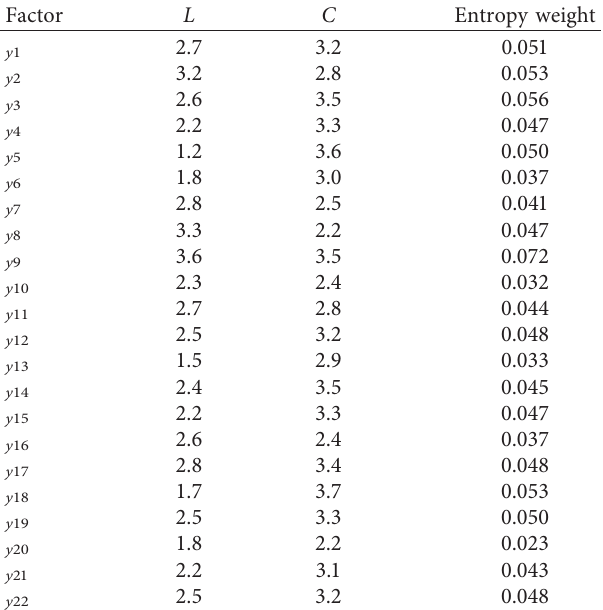
Table 2: Initial value and weight of risk